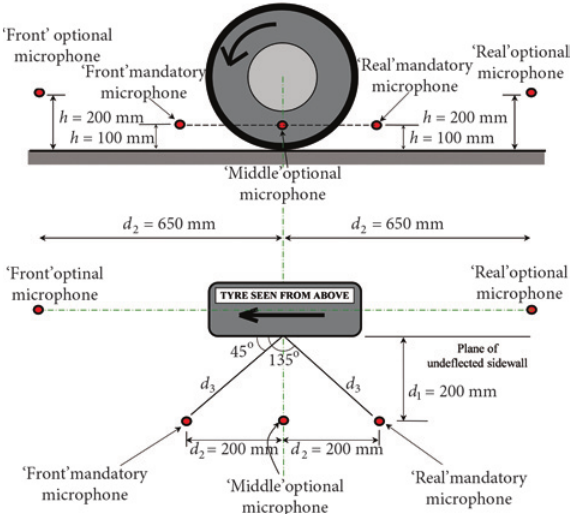
Fig. 1. The suggested positions of the microphones in Close-